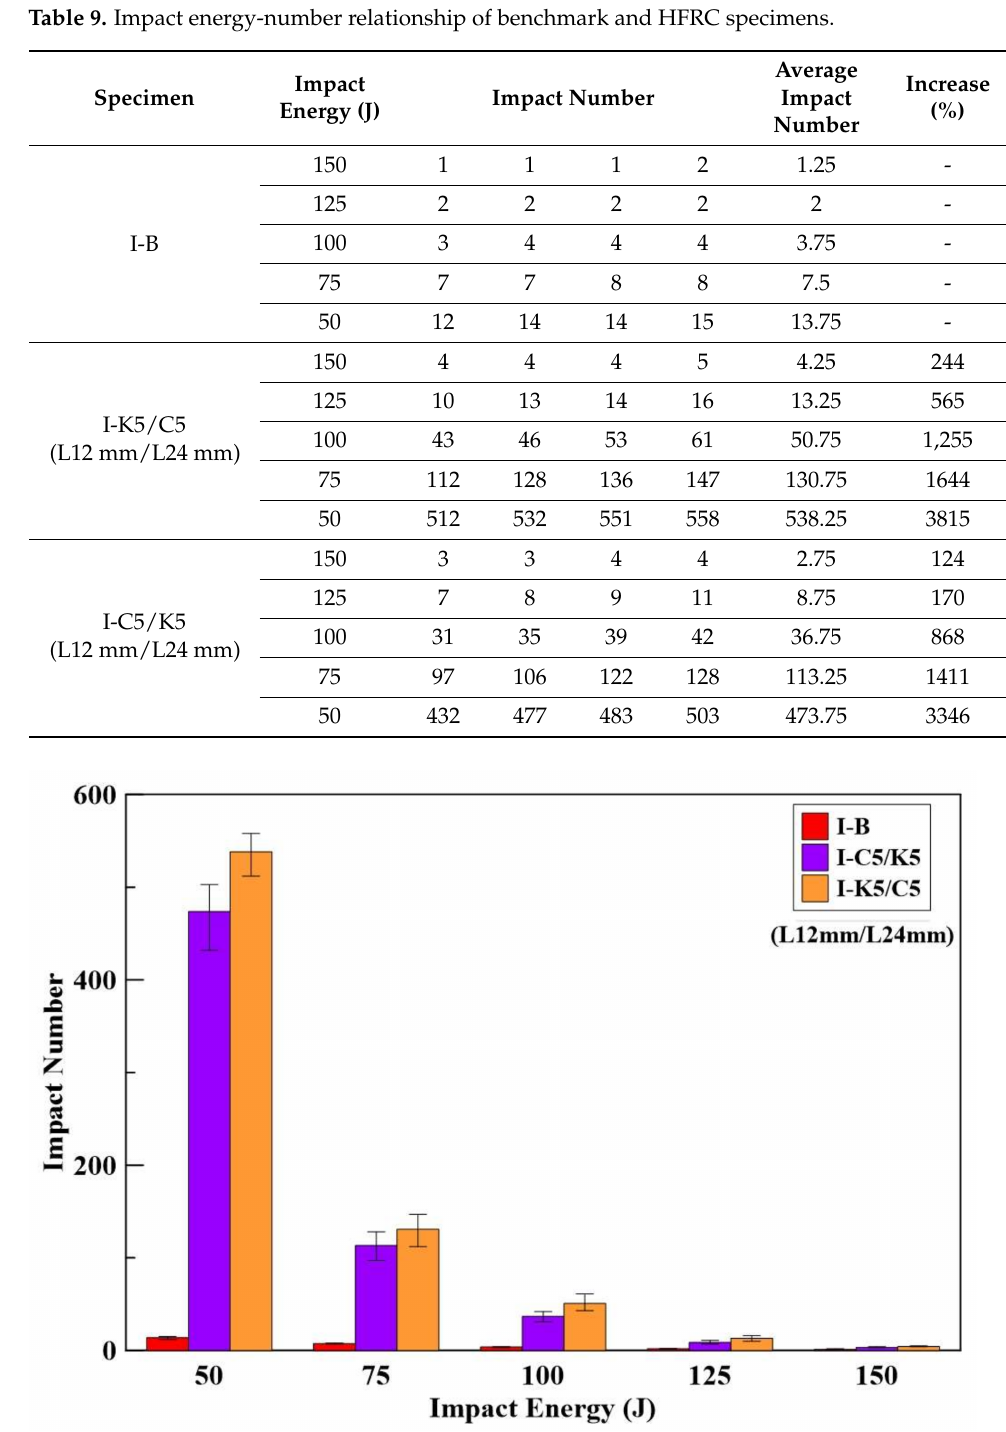
Table 9. Impact energy-number relationship of benchmark and HFRC specimens.